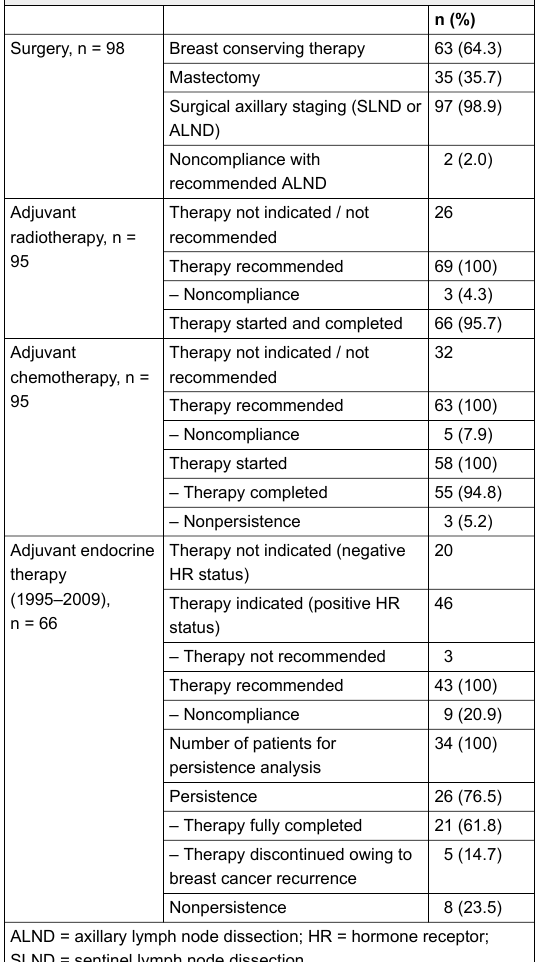
Table 3: Compliance and persistence with breast cancer therapy in the adjuvant